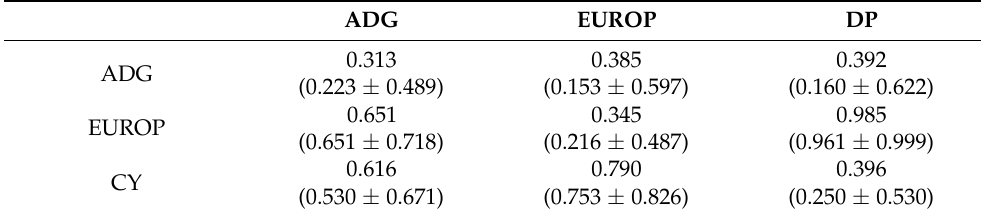
Table 3. Mean of genetic (upper diagonal) and residual (lower diagonal) correlation and heritability (diagonal) between traits in Rendena population, estimated with ssGBLUP. Numbers in parenthesis are the lower and the upper 95% highest posterior density. ADG